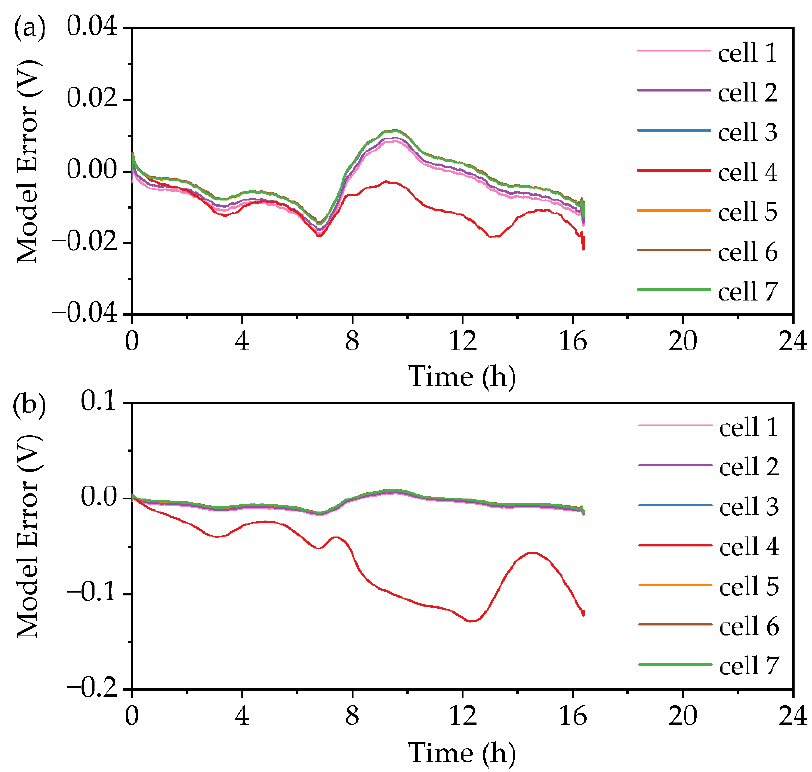
Figure 6. Model errors of each battery during: ( a ) 100 Ω -ER ISC test; ( b ) 10 Ω -ER ISC test.